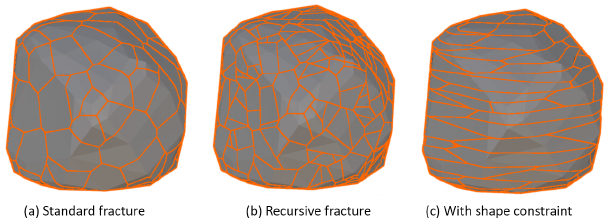
Figure 11. Showing the results of different Voronoi fracturing meth- ods. Recursive fracturing in (b) results in the additional fracturing of the initial convex polyhedra in (a) . Shape constraints in (c) result in the elongation of the convex polyhedra, creating a more sheet-like fracture network.